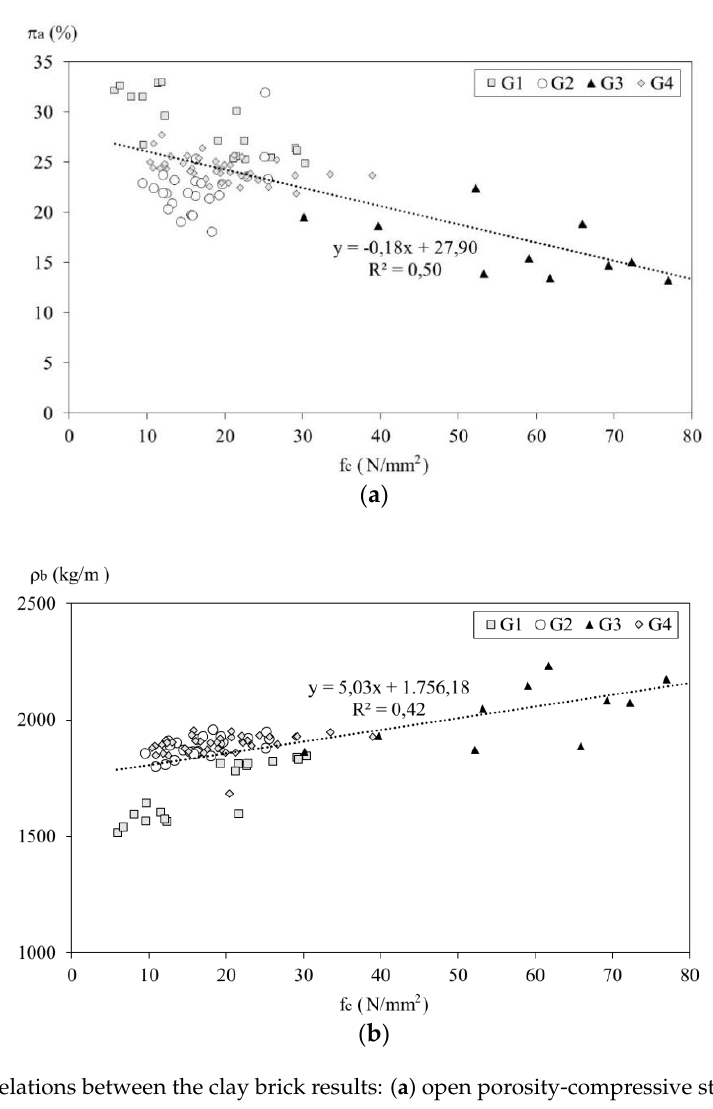
Figure 7. Correlations between the clay brick results: ( a ) open porosity‒compressive strength and ( b ) dry density‒compressive strength.